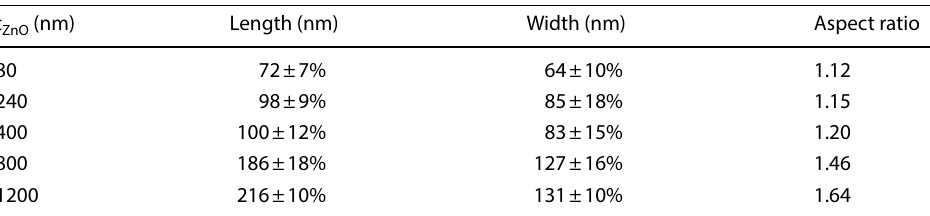
Fig. 3 a Transmittance spectra of ZnO thin films deposited , b Tauc at different t ZnO plot for the ZnO film